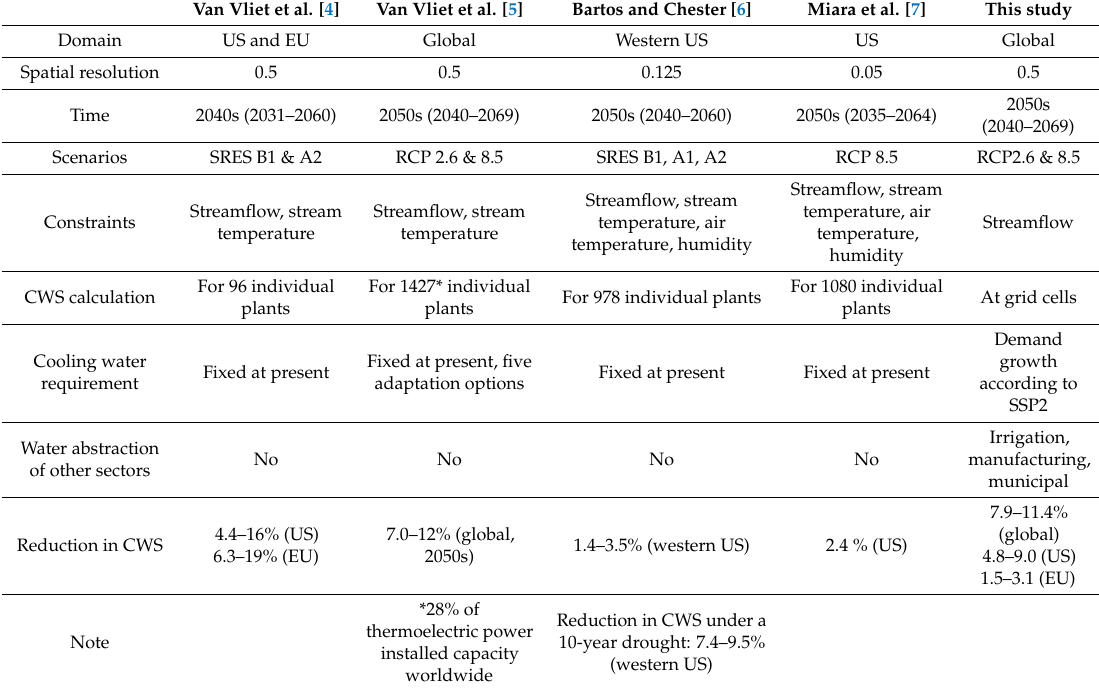
Earlier global estimates of reduction in CWS due to climate change and selected simulation